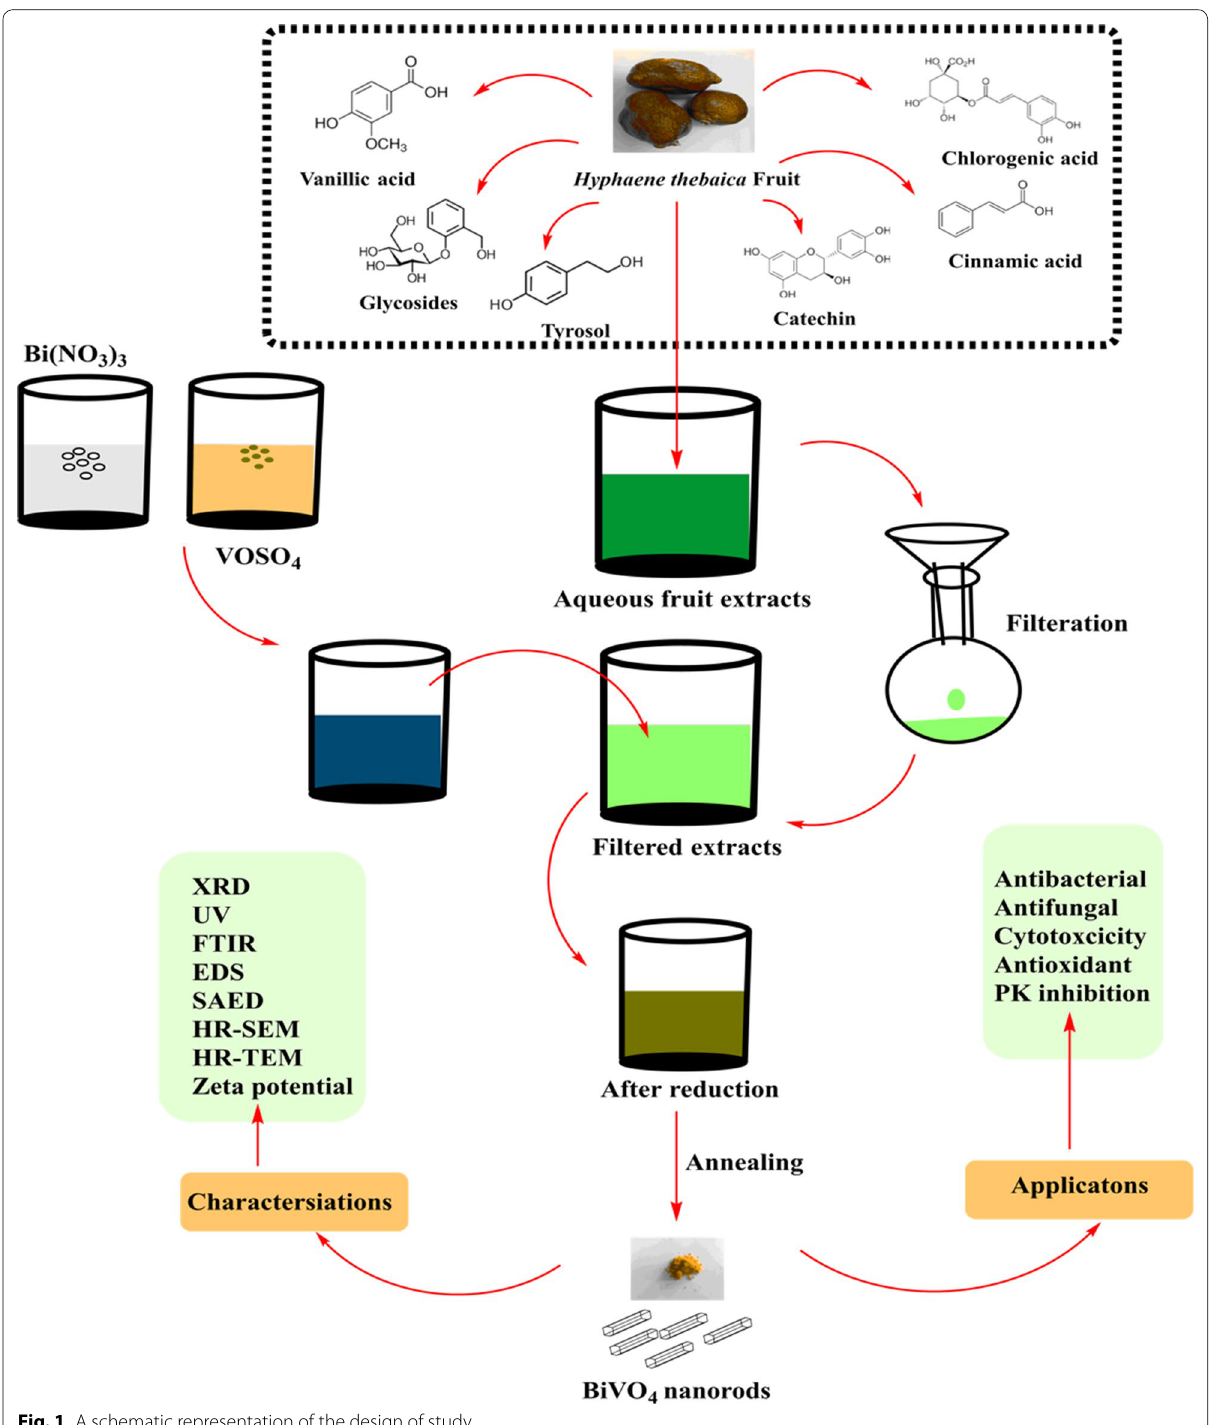
Fig. 1 A schematic representation of the design of